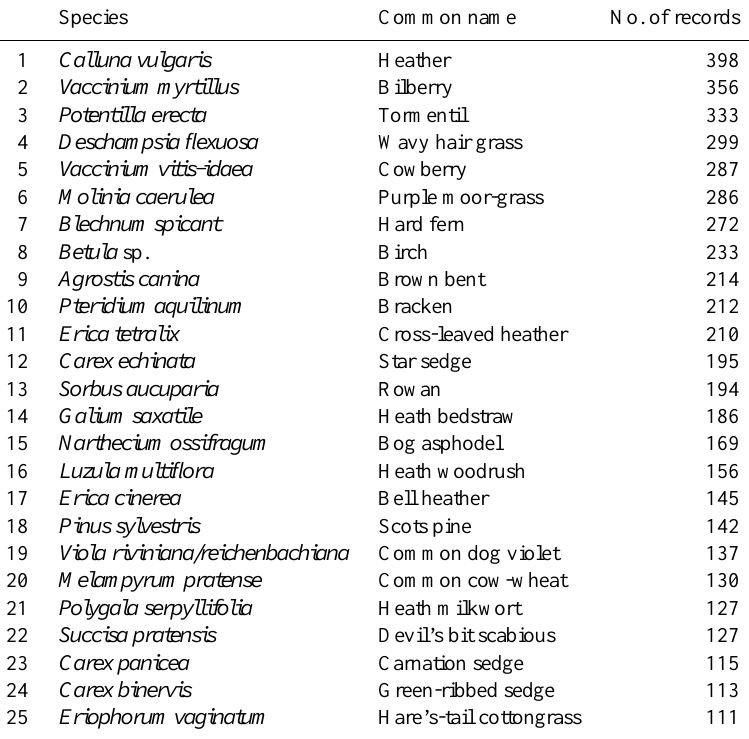
Table 3. List of top 25 ground flora species recorded.